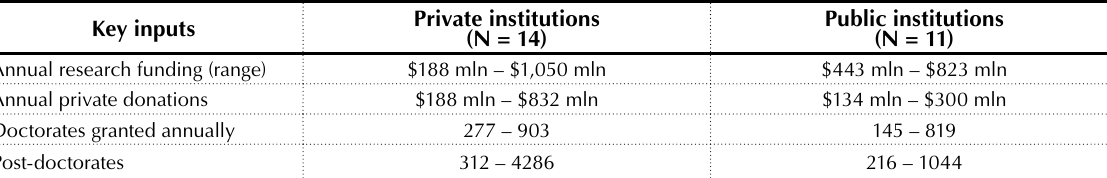
Table 1. Profile of top 25 US research universities (2008) (all figures USD) Source: Data from center for measuring university performance,